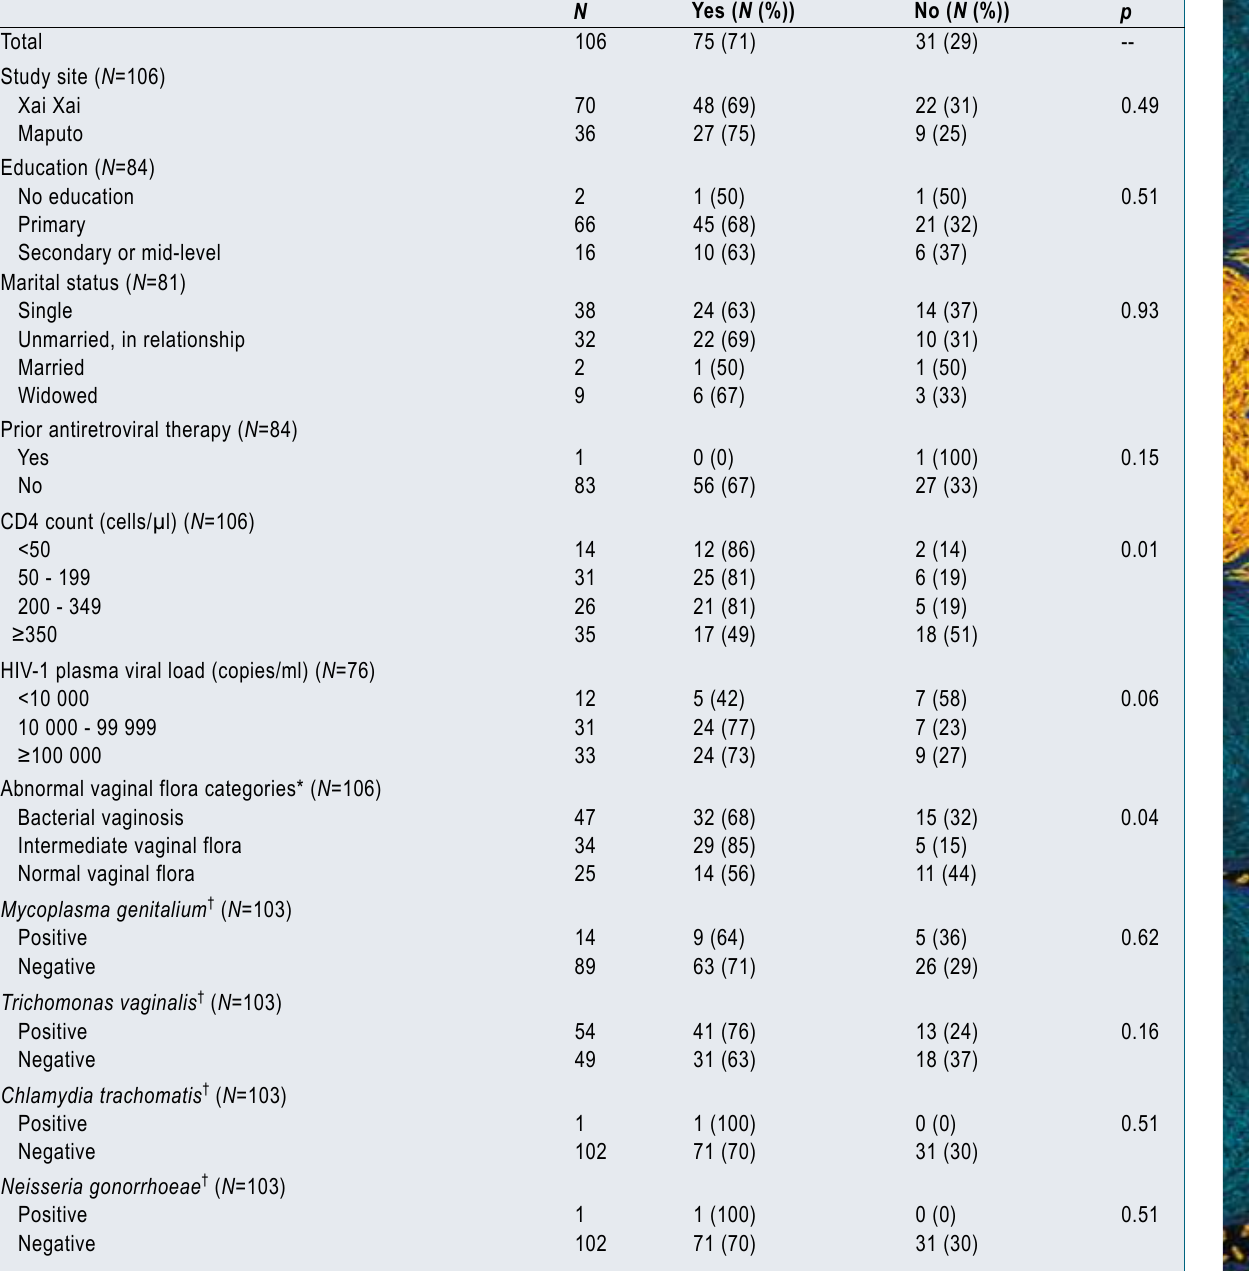
TABLE I. CHARACTERISTICS OF ENROLLED WOMEN AND ASSOCIATION WITH DETECTION OF CERVICAL HIV